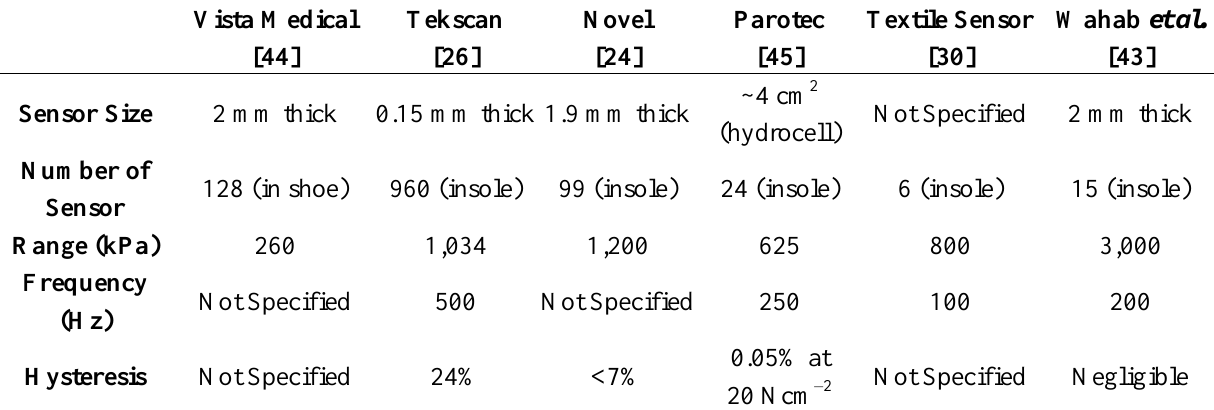
Table 1. Commercially available in-shoe pressure sensors compared to Wahab et al. sensor.